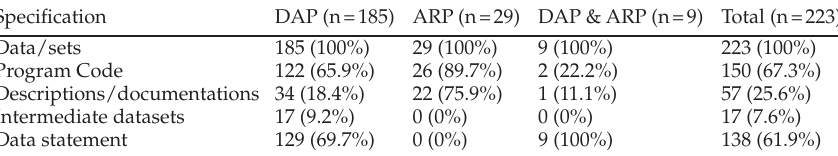
Table 1: Specifications and demands of journal data policies